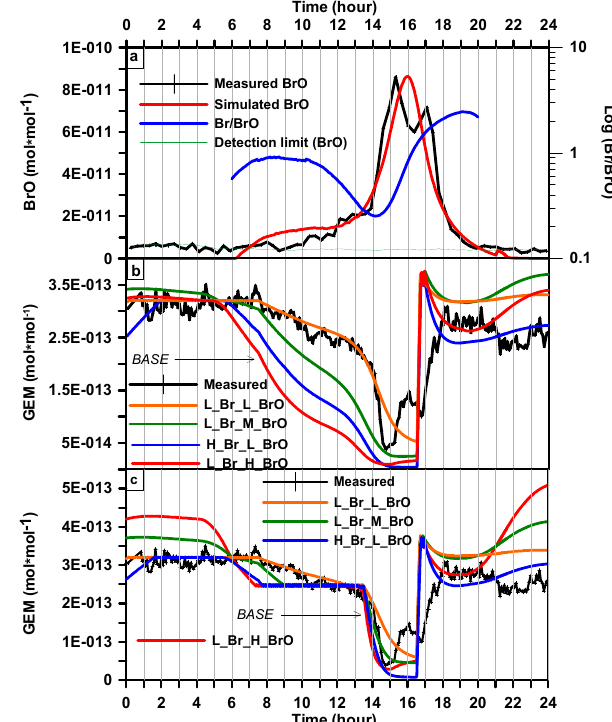
Fig. 2. Simulated and measured diurnal profiles of GEM and BrO. (a) Measured and simulated diurnal profiles of BrO, and simulated diurnal profile of [Br]/[BrO] for Julian day 188. (b) GEM diurnal profiles for different combinations of k GEM + BrO and k GEM + Br val- ues. (c) Same as (b) with simulated GEM mixing ratios being con- strained between 07:30 and 13:30LT. Note that constrains of fluxes were not added during AMDEs which was the main emphasis of our